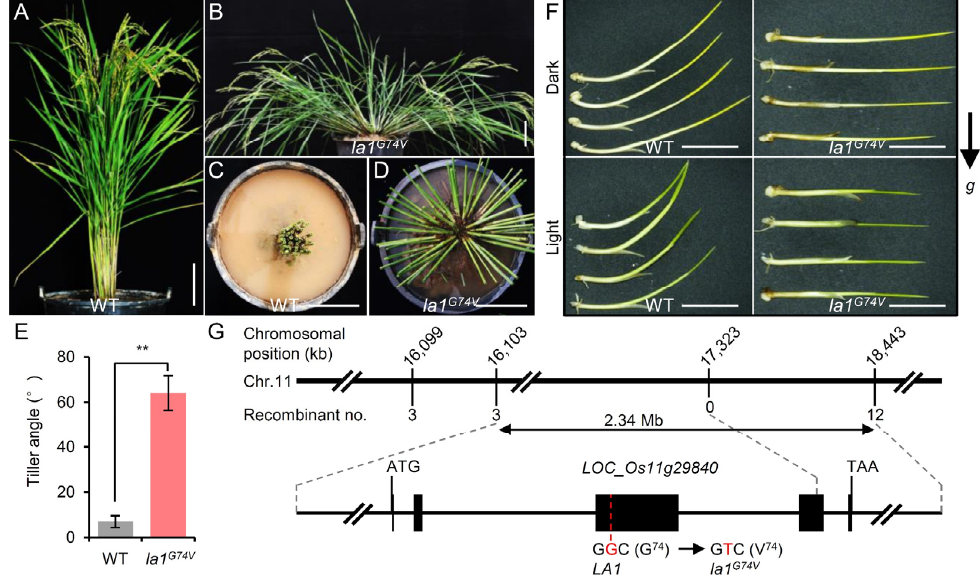
Figure 1. Mapping and phenotype of the spreading-tiller mutant la1 G74V . ( A – D ) Plant architectures of the wild-type (WT) plant and the la1 G74V mutant. Scale bars, 10 cm. ( E ) Comparison of tiller angles between WT and la1 G74V . Values are the mean ± SD (**, p < 0.01, n = 10). ( F ) Five-day-old seedlings of WT and la1 G74V after 12 h gravistimulation under vertical light (top) or dark (bottom) conditions. The arrow indicates the direction of gravity. g, gravity. Scale bars, 1 cm. ( G ) Fine mapping of LA1 . LA1 is located in a 2.34 Mb region between 16,103 and 18,443 molecular markers. Black boxes indicate exons of LA1 . The marker 17,323 is located in the fourth exon of LA1 . A non-synonymous G-to-T mutation was identified in the third exon of LOC_Os11g29840 (LA1), causing a substitution of the 74th amino acid from glycine (G) to valine (V).